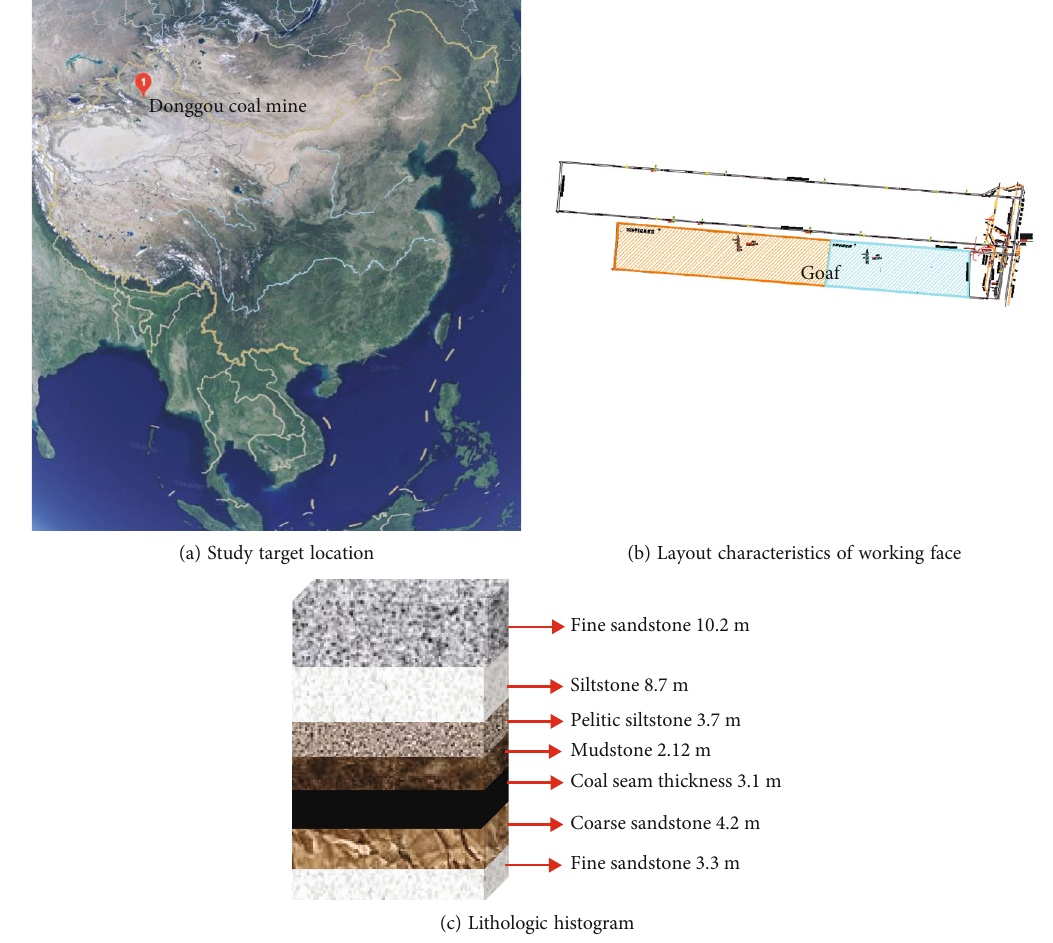
Figure 1: Research target location and project overview.